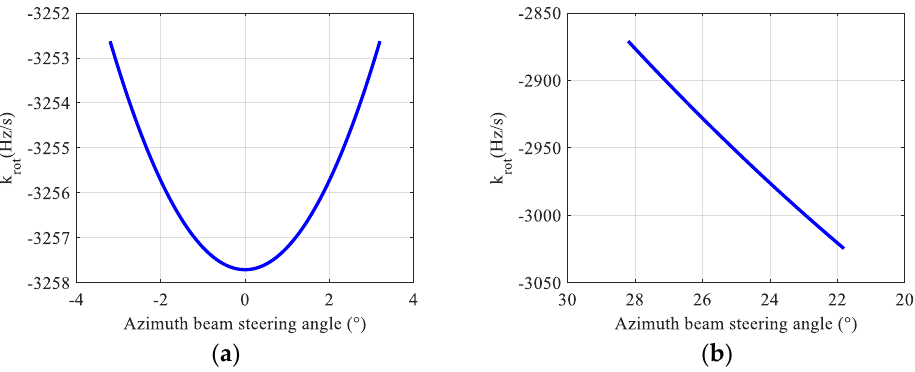
Figure 8. Variation curves of the instantaneous Doppler centroid varying rate k rot under the side-looking and the squint. ( a ) k rot within ± 3.2 under the side-looking; ( b ) k rot within ± 3.2 under the squint angle 25 ° .